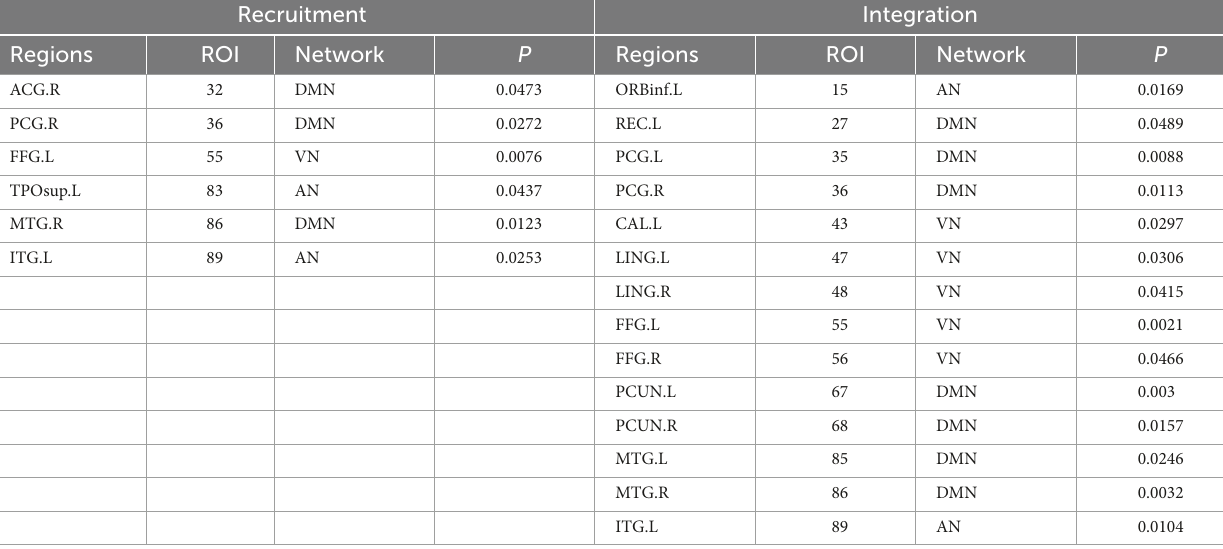
TABLE 2 Brain regions showing significant differences in recruitment and integration. Recruitment Integration Regions Regions